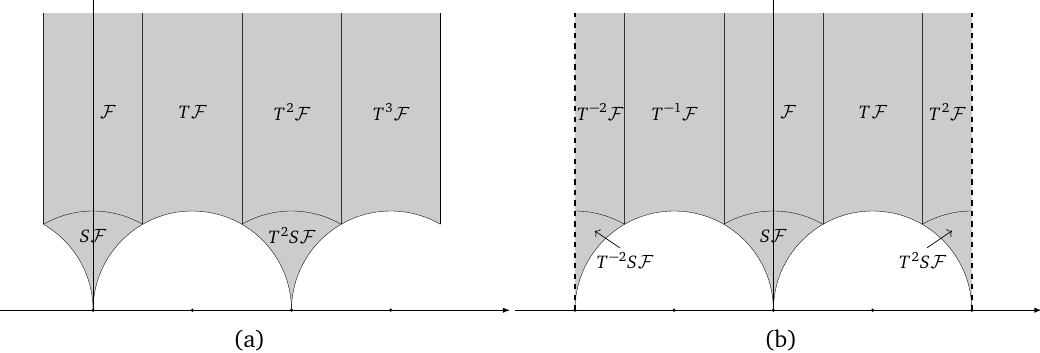
Figure 4: Fundamental domains for Γ 0 ( 4 ) . Figure (a) shows a standard choice, with width one cusps at τ = 0 and 2, while in figure (b) the cusp at τ = ± 2 is split, with the branch cut of the periods indicated by the dashed